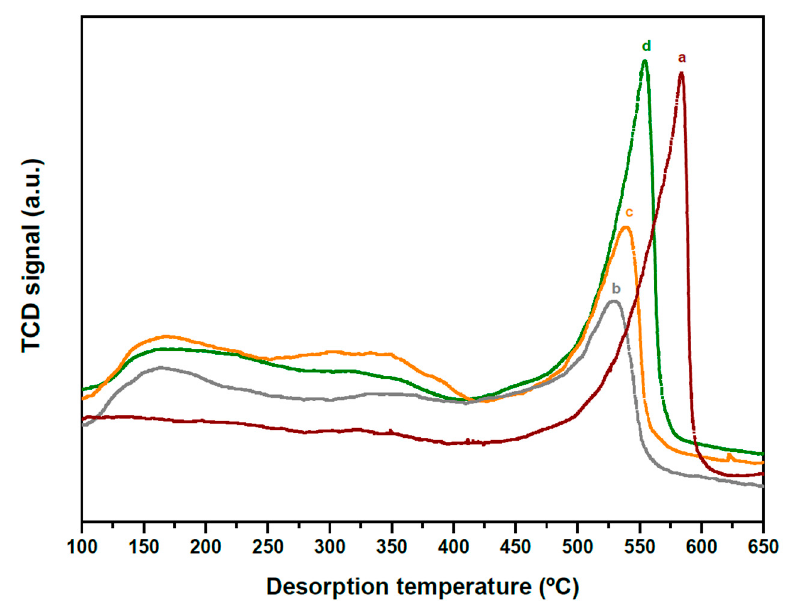
Figure 5. TPD-NH 3 profiles of bulk HPW (a) and xHPW / Ti acid catalysts: 1.4HPW / Ti (b), 1.7HPW / Ti (c) and 2.7HPW / Ti (d). Table 2. Quantitative data from TPD-NH 3 profiles of xHPW/Ti acid catalysts.